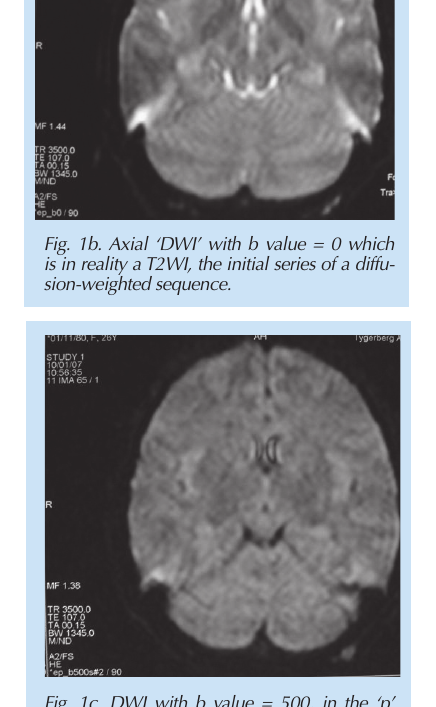
Fig. 1c. DWI with b value = 500, in the ‘p’ direction – phase encoding gradient or y-axis.